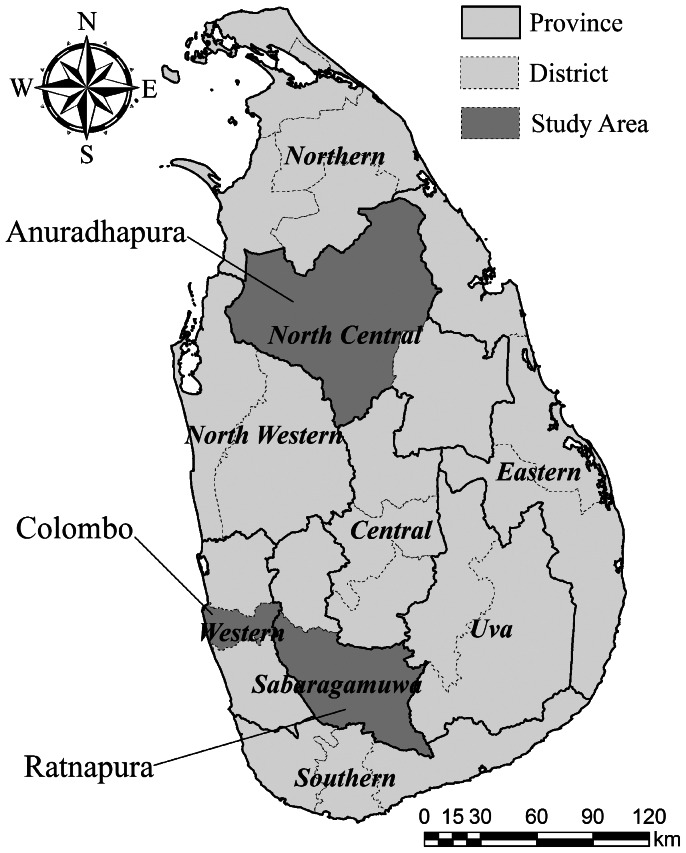
Study Locations.